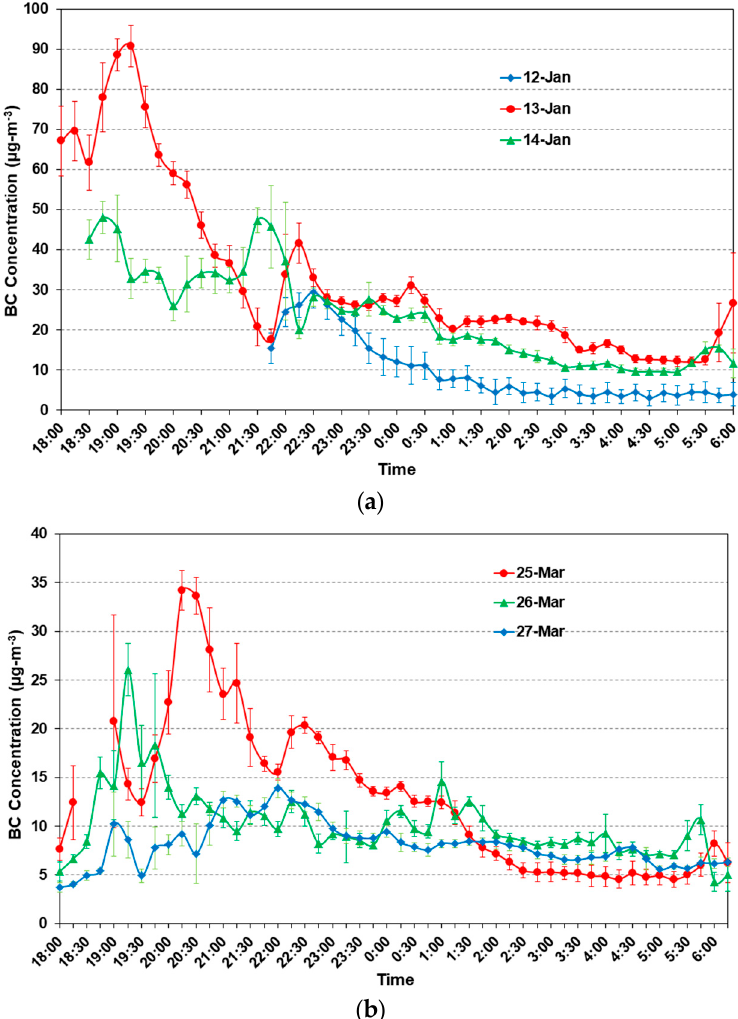
Figure 5. ( a ) Night time BC profile with standard deviation (15 min average), observed at fixed campaign site for the days 13, 14 and 15 January 2013; ( b ) Same as ( a ), but for 25, 26 and 27 March 2013.